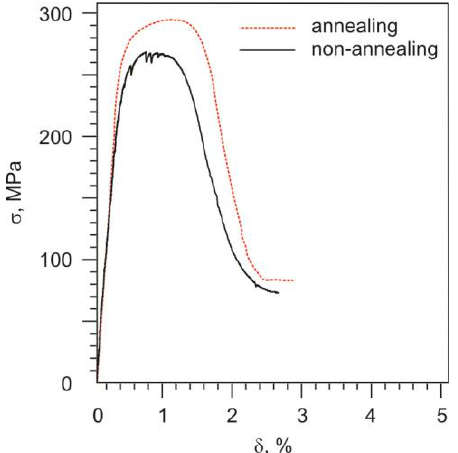
Figure 10. Stress – strain curves for the 3.5-mm diameter composite sample without and with intermediate annealing during forging.